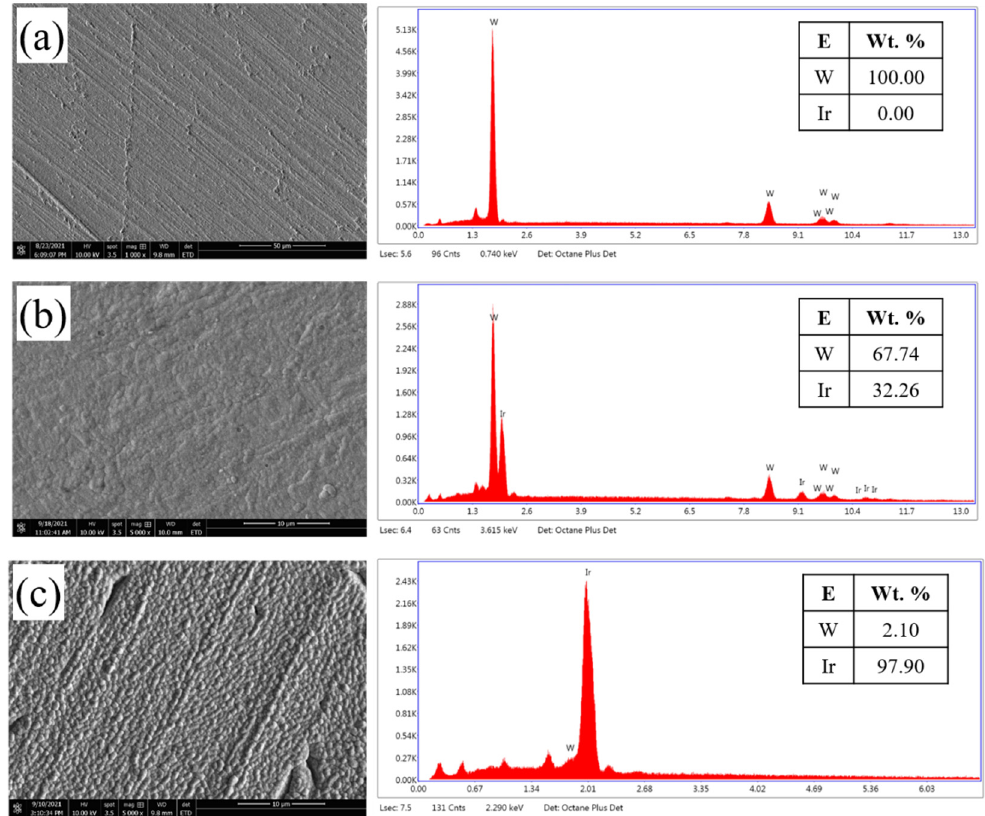
Figure 2. Surface morphology and energy spectrum analysis of tungsten specimens after iridium- electroplating for 8 h: ( a ) electroplating without activation, ( b ) chemical activation for 2 min, ( c ) electrochemical activation at Da = 2 A/dm 2 for 2 min.